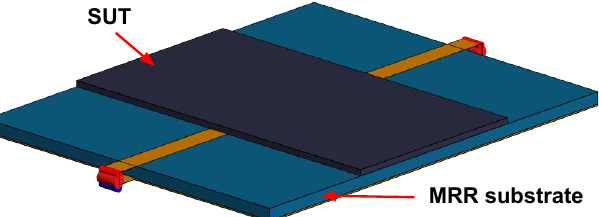
Figure 1. A computational model of an MRR with a SUT placed over it (e.g., TLX-8 is the SUT